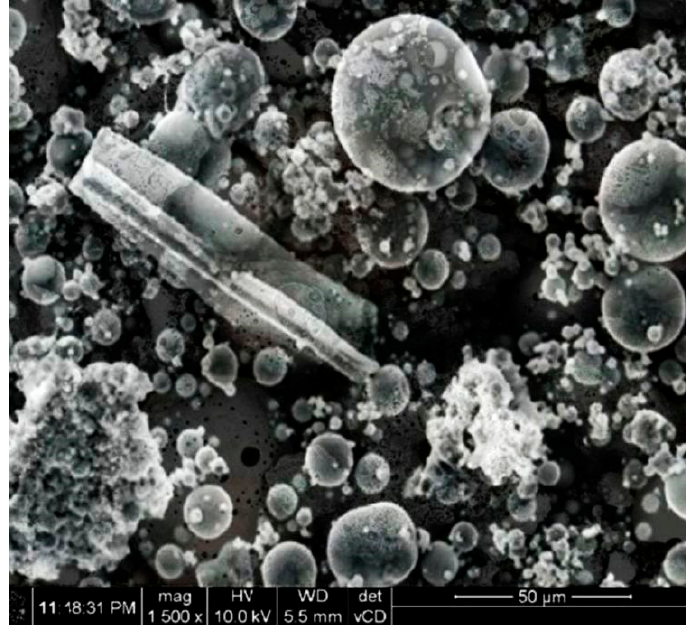
Figure 7. Morphology of calcareous fly ash grains batch B (magnification of 1500 times).